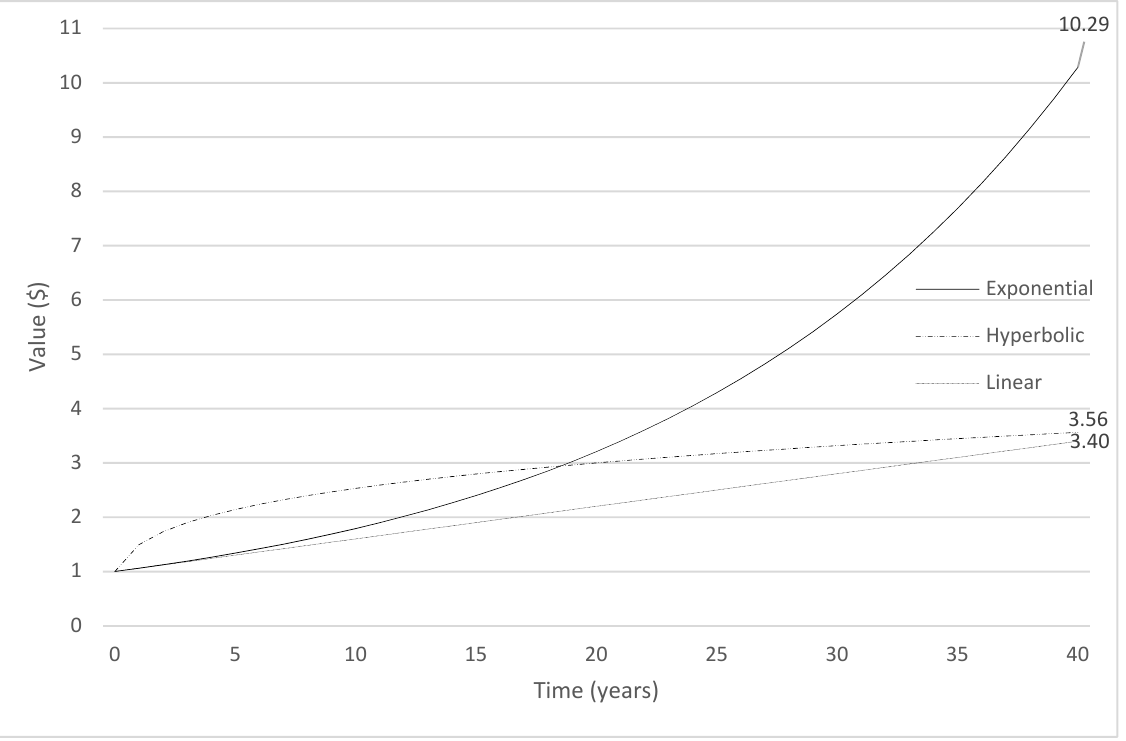
Figure 2. Three projection methods.